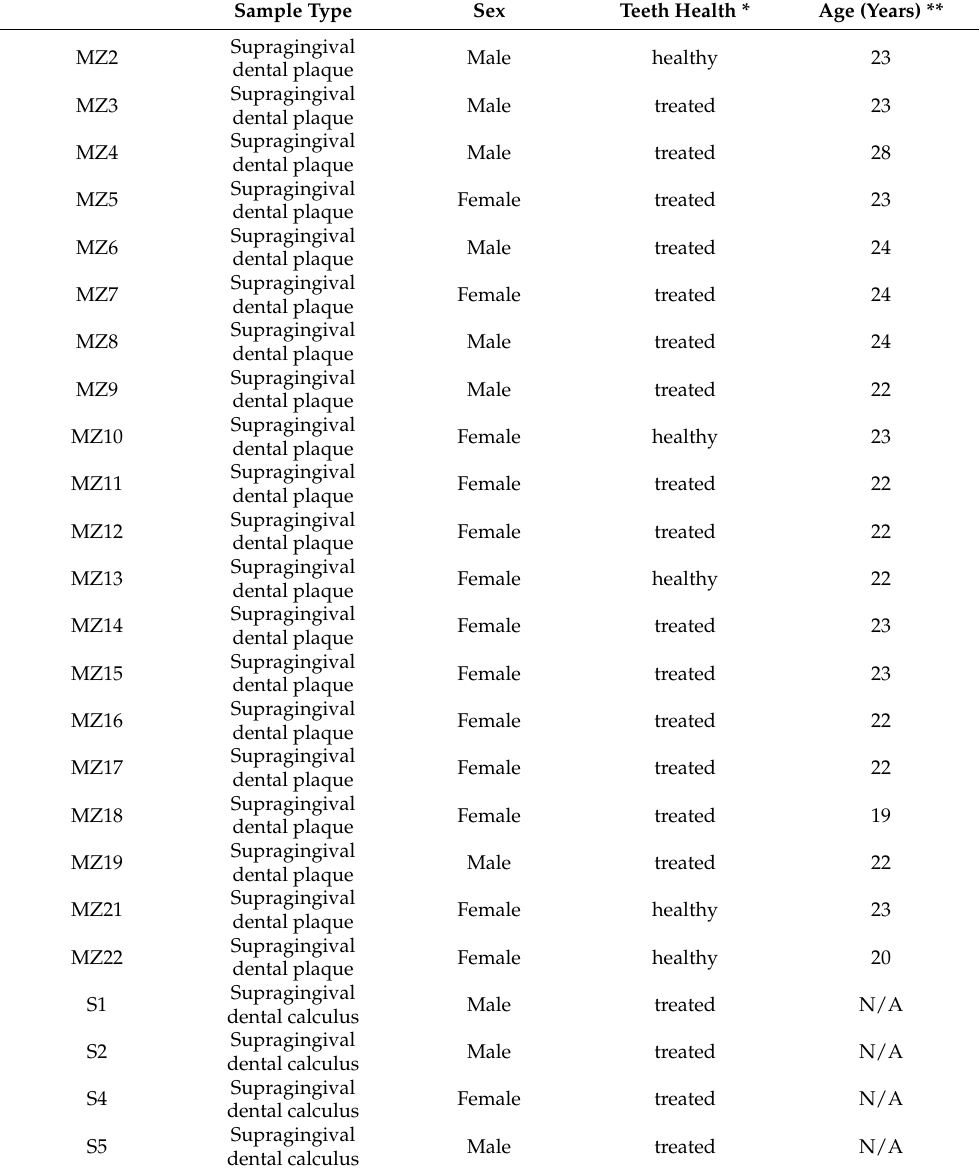
Table 2. Characteristics of modern